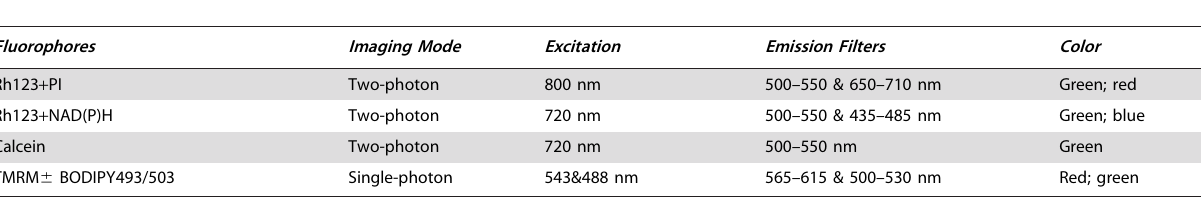
Table 2. Intravital Confocal/Multiphoton Microscopy Settings.